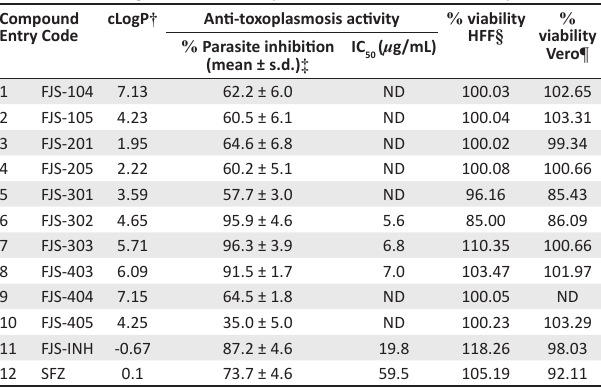
TABLE 2: Screening of chemical compounds for anti-RH-GFP efficacy. Compound Entry